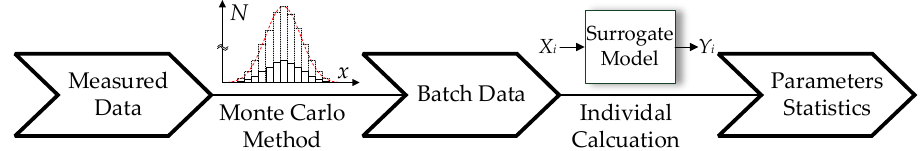
Figure 6. Procedure of the calculation of the quality performance.